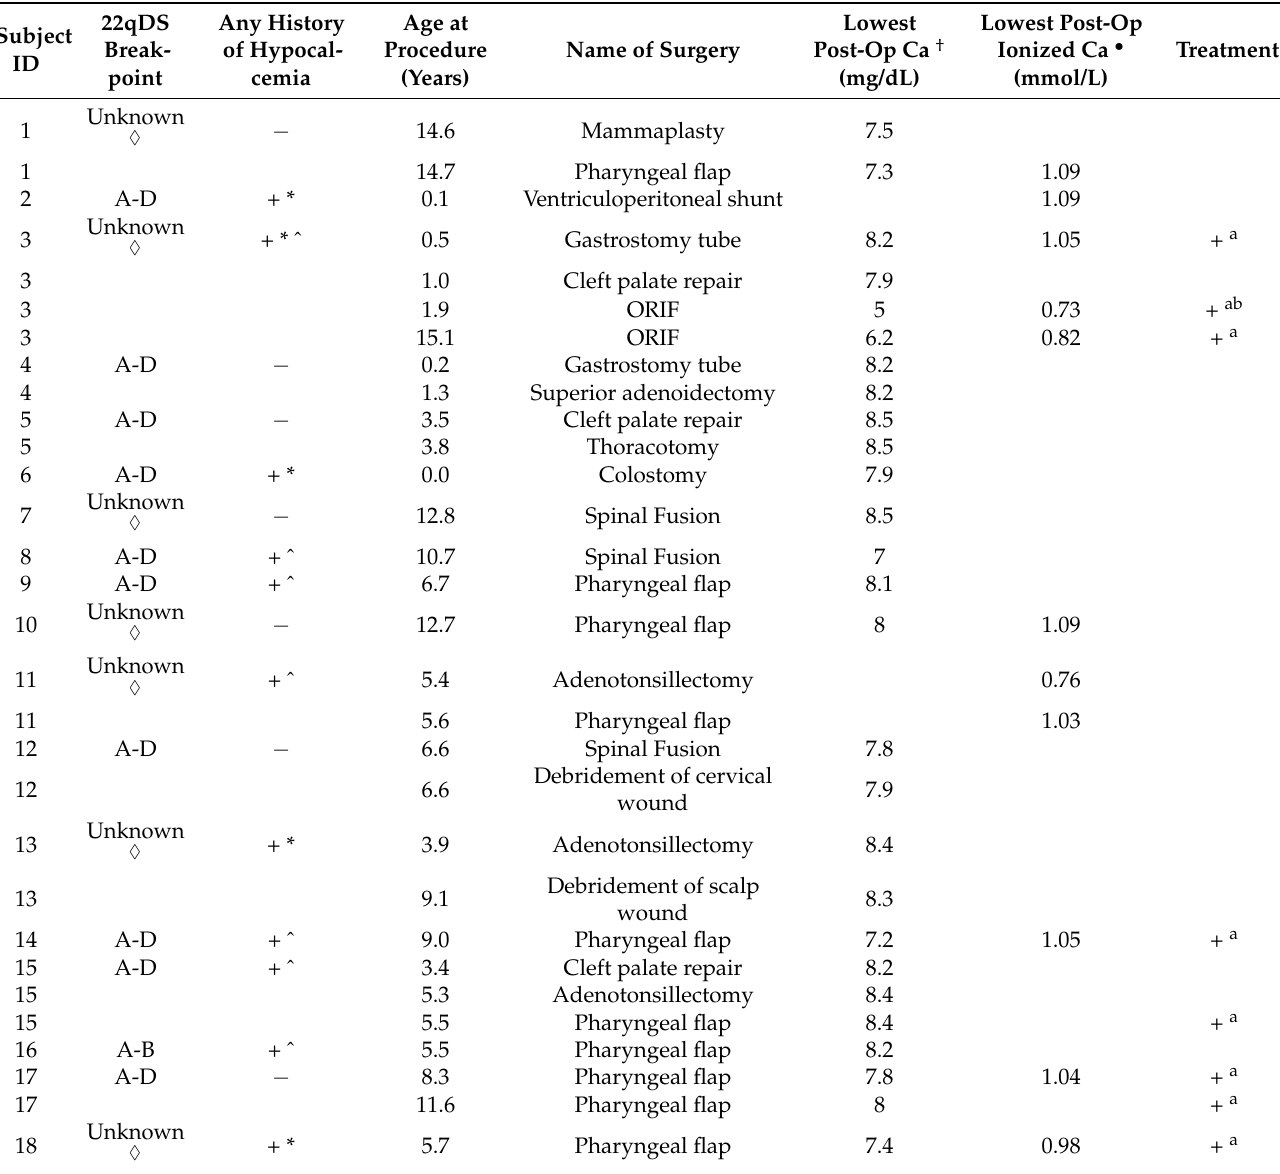
Table 3. Postoperative hypocalcemia found in patients who underwent only non-cardiac